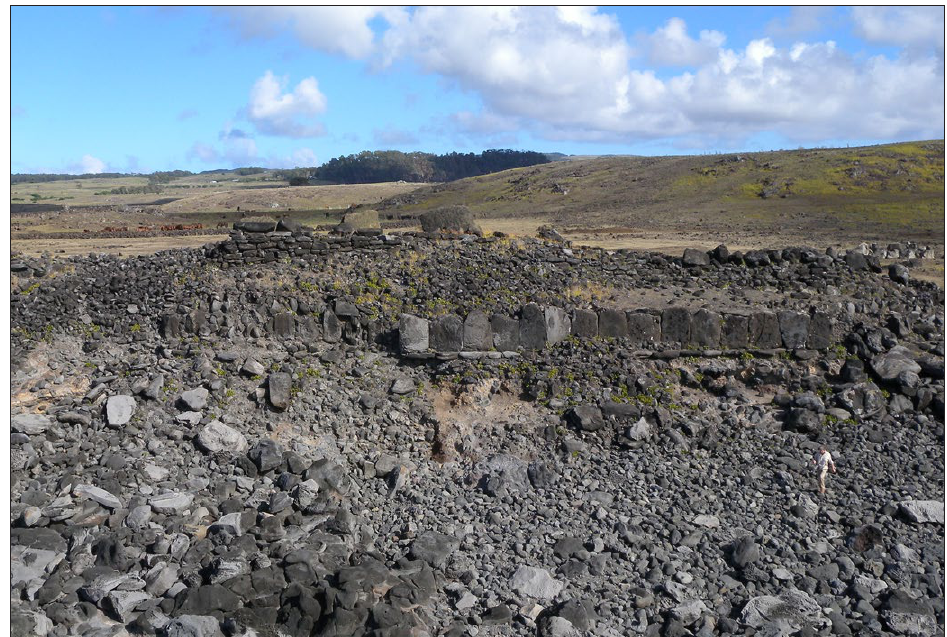
Figure 1: The rear of Ahu Ura Ura ŋ a Te Mahina, on the south coast of the Island. Sea erosion of the low cliff on which it stands has reached its rear wall, and is causing it to collapse (in the photo, the collapse is advancing from the left to the right). The bases of three prone moai are partially visible at the top of the surviving platform. Photo: Adam